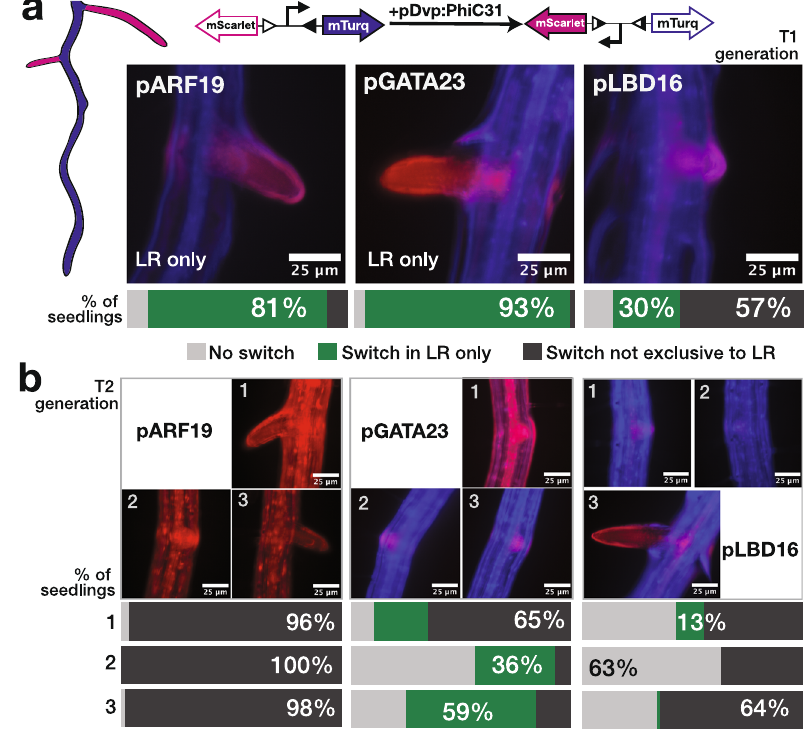
Fig.2|PhiC31integraseswitchunderthecontrolofdevelopmentalpromoters. a Developmental (Dvp)promotersdrove the expression ofPhiC31 integrase with a target that switches from mTurquoise2 to mScarlet when the integrase is active. Target lines were transformed with the integrase constructs, and at least 20 T1seedlingsperintegraseconstructswerecharacterized.Representativeimagesof emergedlateralrootsareshownforeachpromoter-integraseconstruct,aswellasa bar representing the percentage of seedlings in each phenotypic category: no